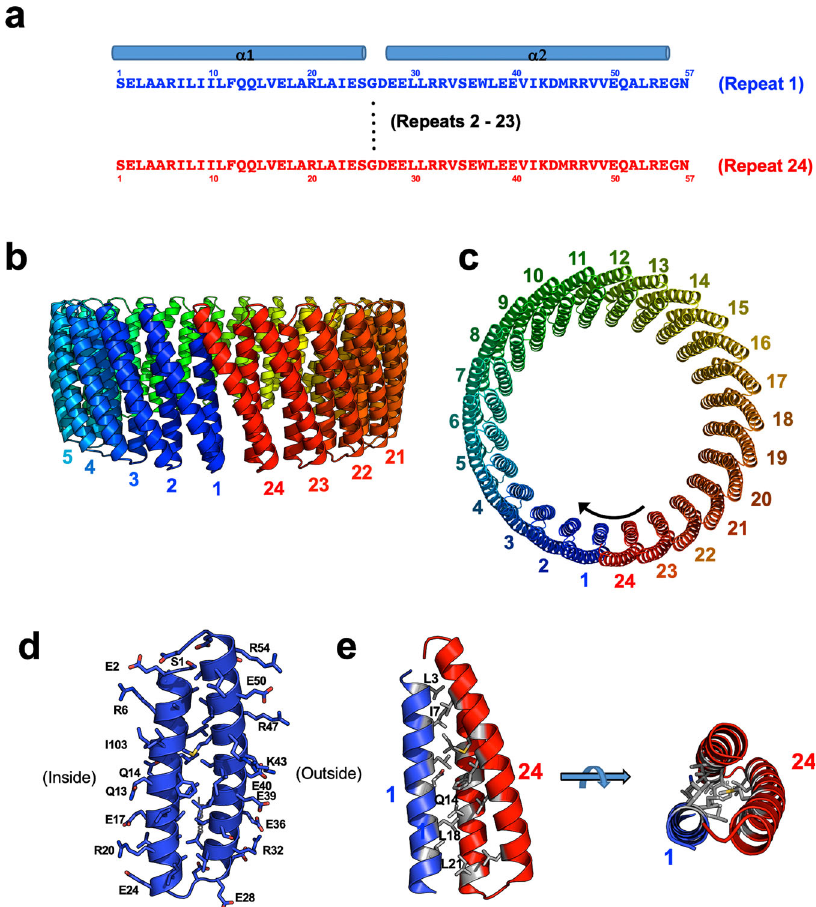
Fig. 2 Design of tcTRP24. a Sequence and secondary structure of individual repeats, which each consist of an anti-parallel two-helix bundle connected by short turns composed of ‘ GD ’ sequences. b , c Twenty-four consecutive repeats (colored blue at the N-terminal repeat and progressing to red at the C-terminal repeat in all fi gure panels) form a closed cylindrical structure, with an exterior diameter of ~100 Å and an interior pore diameter of ~60 Å. d The structural composition of the two-helix bundle corresponding to each designed repeat is chemically similar to that of the tcTRP9 design (Fig. 1), again placing mostly charged glutamic acid and arginine residues on the exterior of the particle, and a network of charged and hydrophilic residues on its interior surface. e The interface between individual